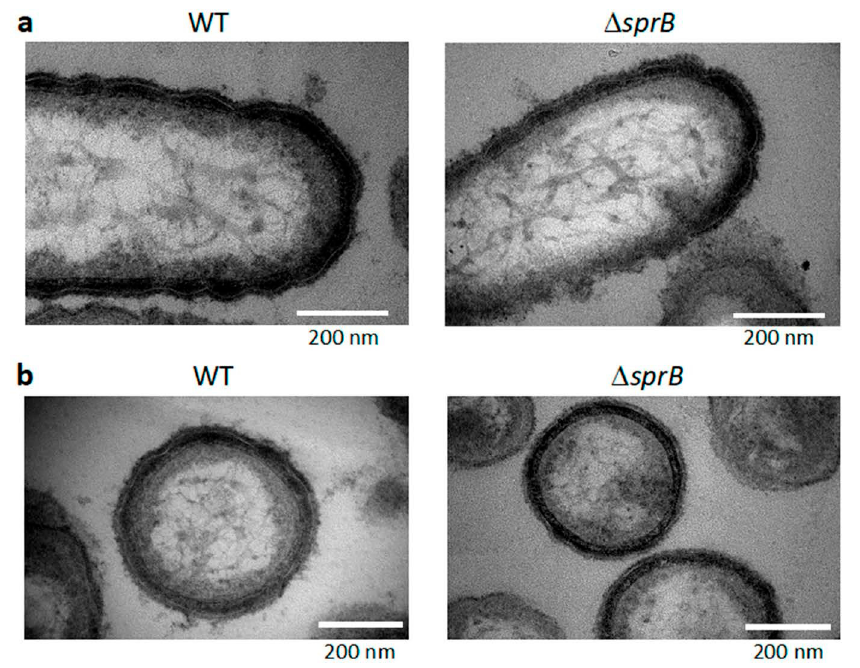
Figure 8. TEM images of buffer-washed WT and ∆ sprB cells isolated from their colonies formed on the agar. Cells were isolated from a few mm-zone from the edges of WT and Δ sprB colonies formed on 1% A-PY2, washed with the washing buffer, and aldehyde fixed. After dehydration, the cells were embedded in Epon. The samples were 70 nm thick thin-sectioned, stained, and imaged by TEM. ( a ) Thin-sections along the long axis of cells. ( b ) Thin-sections along the short axis of cells. After the washing, surface coat structure was not observed. The undulations of the remaining outer membrane were still observed for both WT and Δ sprB cells.